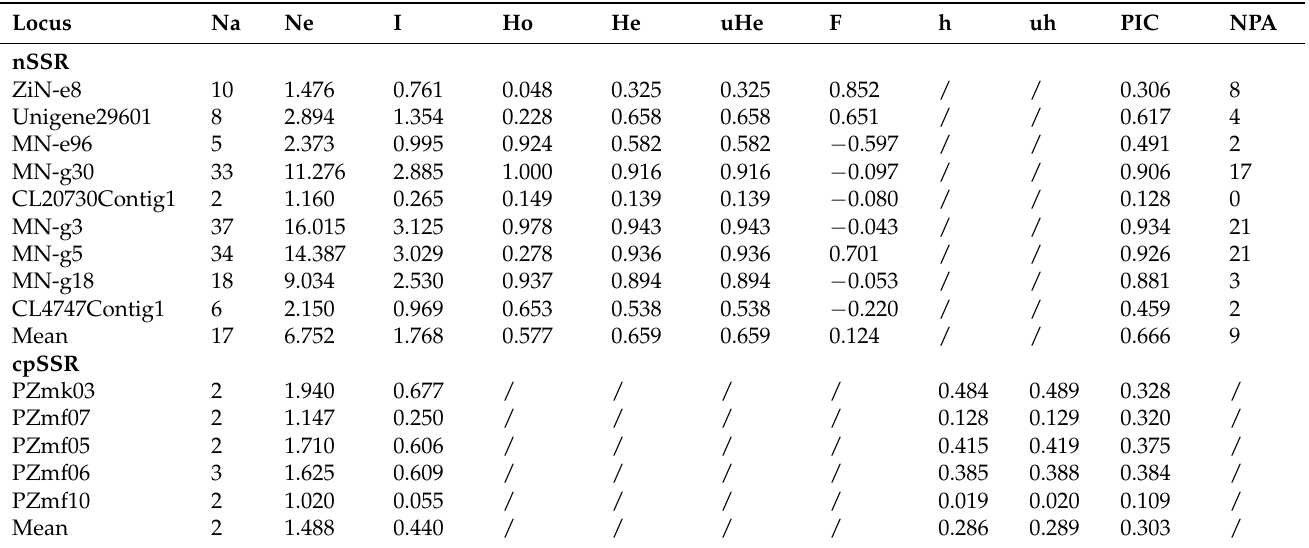
Table 2. Diversity statistics of the nSSR and cpSSR markers on 102 P. zhennan